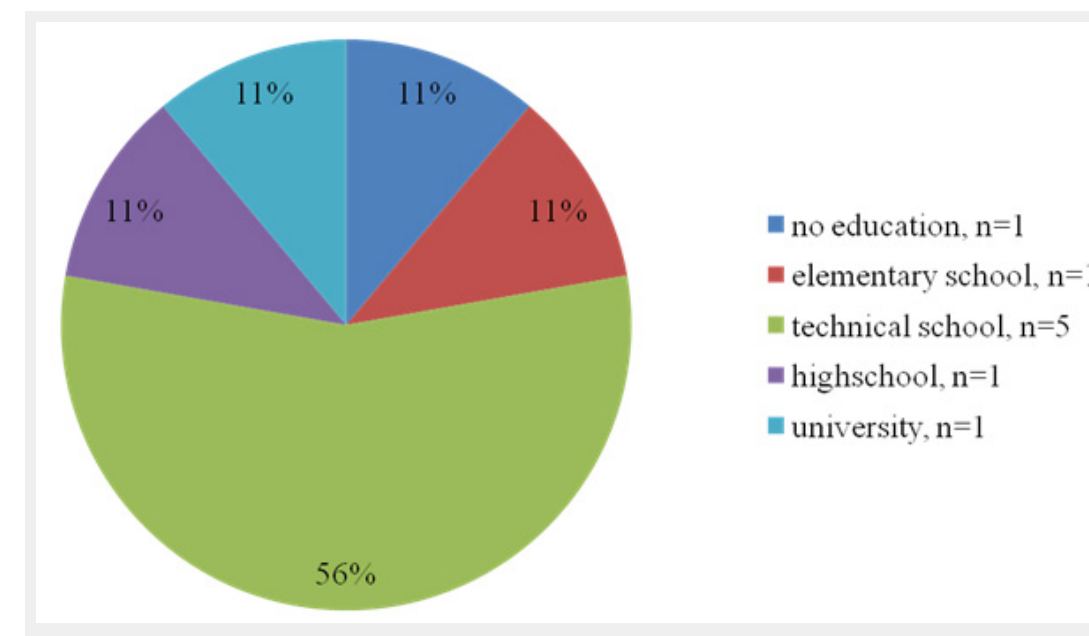
Figure 4 Knowledge of BAG/BASPO recommendation. Nine (38%) of the 24 patients knew about the BAG/BASPO recommendation: one (11%) patient was a graduate of an elementary school, 5 patients (56%) of a technical school, one patient (11%) of high school, one patient (11%) of the university and one (11%) patient had no educational